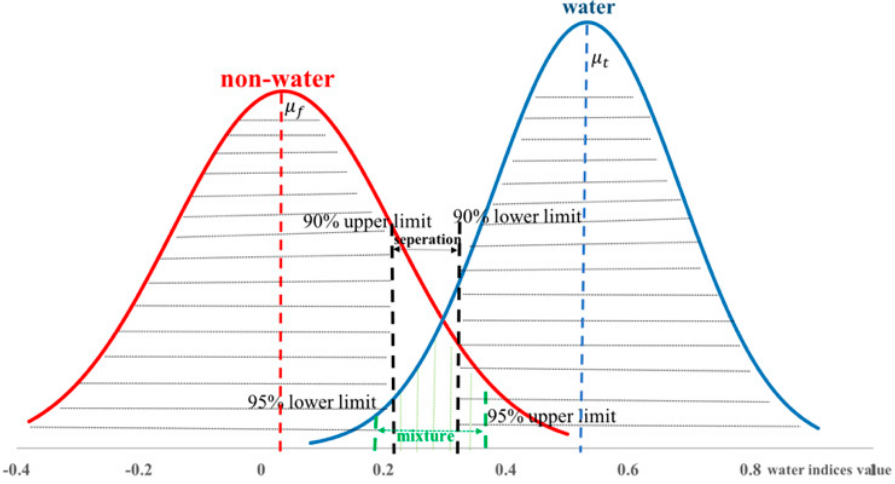
Figure 4. Pixel distribution between water and non-water areas.